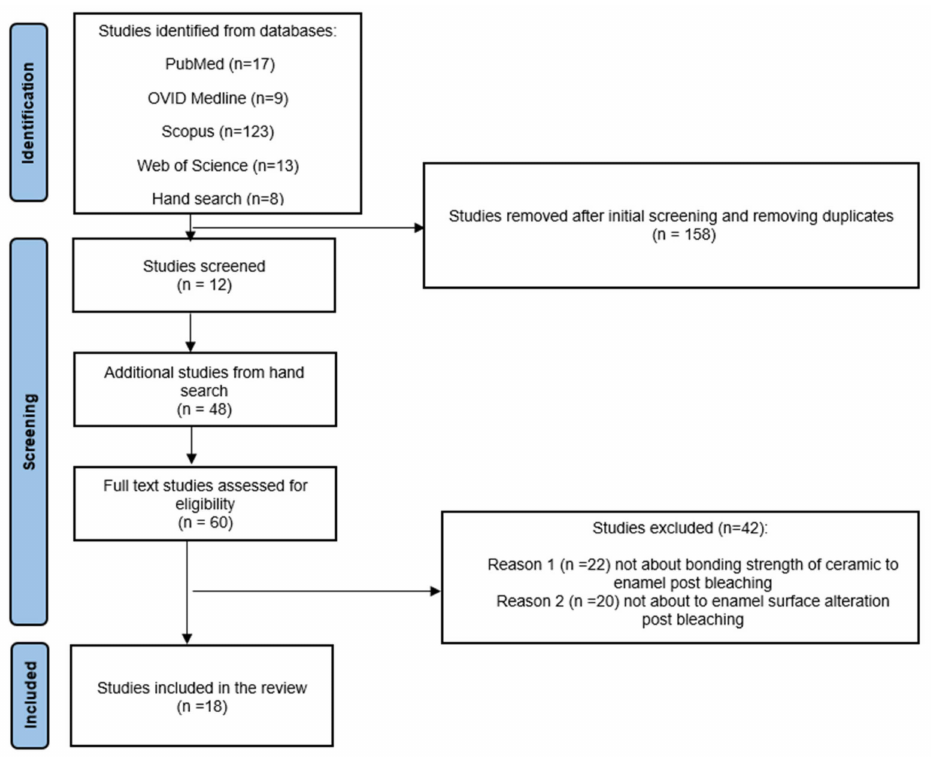
Figure 1. PRISMA flow diagram summarising the selection